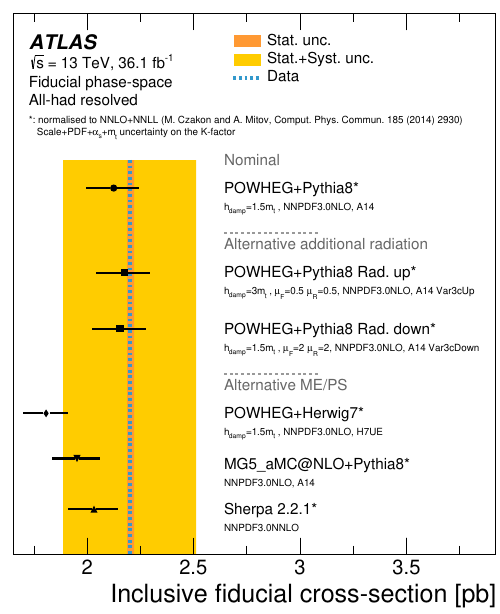
Figure 22 . Comparison of the measured inclusive fiducial cross-section with the predictions from several MC generators. The yellow band represents the total uncertainty in the data. The orange band represents the statisical uncertainty only. The uncertainty in the cross-section predicted by each NLO MC generator only includes the uncertainty (due to scales, PDFs, m the K -factor used in the normalisation.